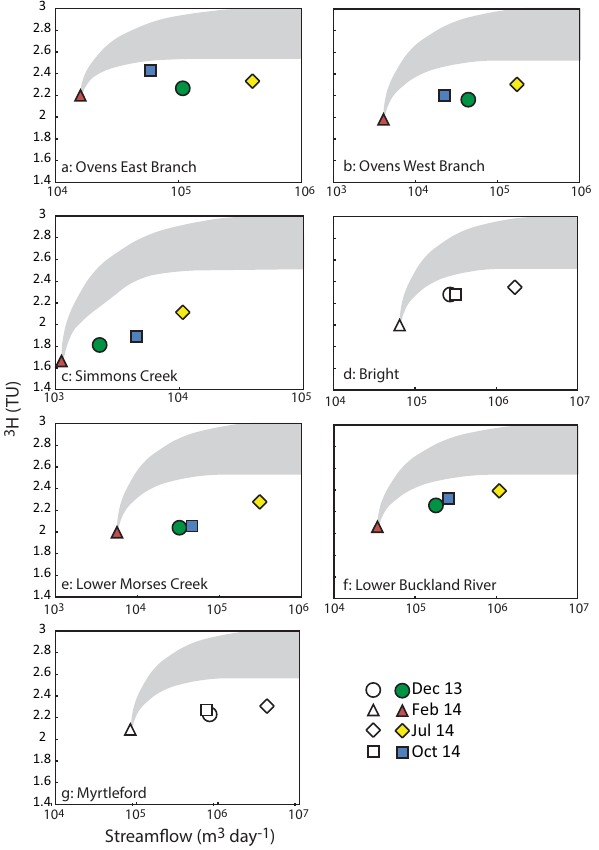
Figure 4. 3 H activities vs. streamflow for the main Ovens River (open symbols) and its headwater tributaries (closed symbols); data from Table 1. Shaded fields depict mixing between baseflow, which is assumed to have a 3 H activity of the lowest streamflow at each site, and rainfall with a 3 H activity of between 2.5 and 3.0TU, which spans the range of rainfall 3 H activities in Table 1 constructed using Eq. (4). The mixing model overestimates the 3 H activities recorded at higher flows at all sites.